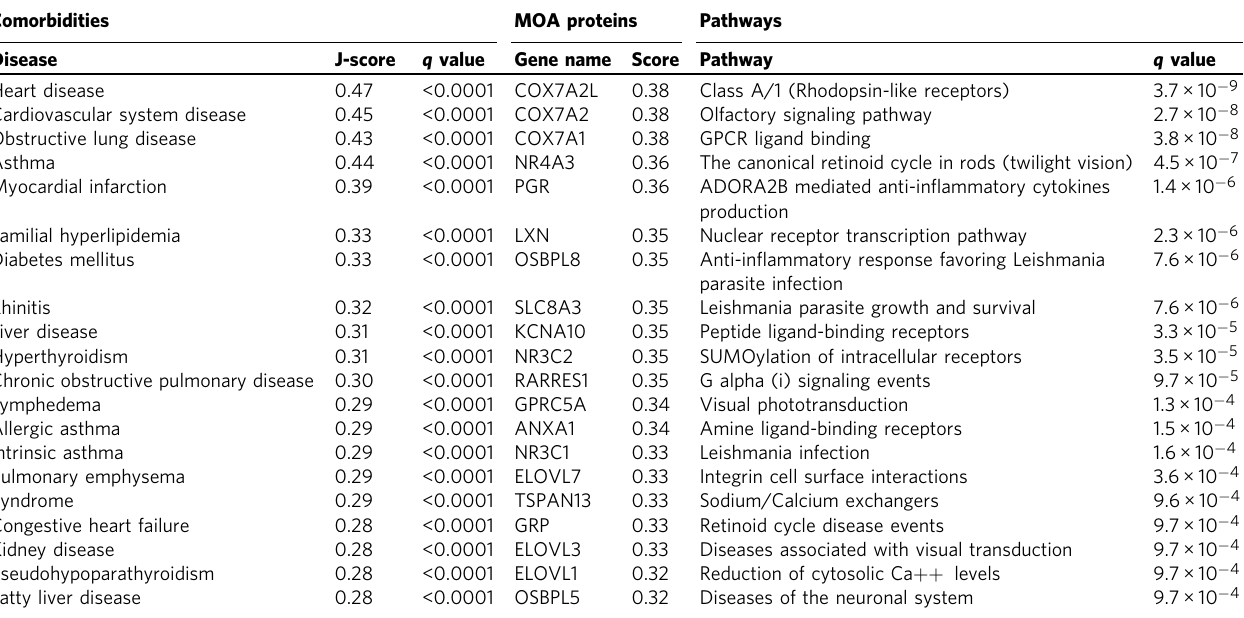
Table 2 Top 20 comorbidities (excluding same disease pair, (i.e., CAD-CAD)), top 20 comorbidity enriched MOA proteins (with respect to original disease), and top 20 pathways associated with the prediction CAD